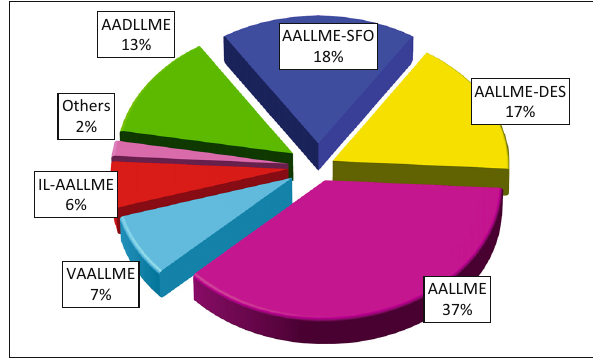
Figure 4: The various modes of the air - assisted liquid – liquid microextraction